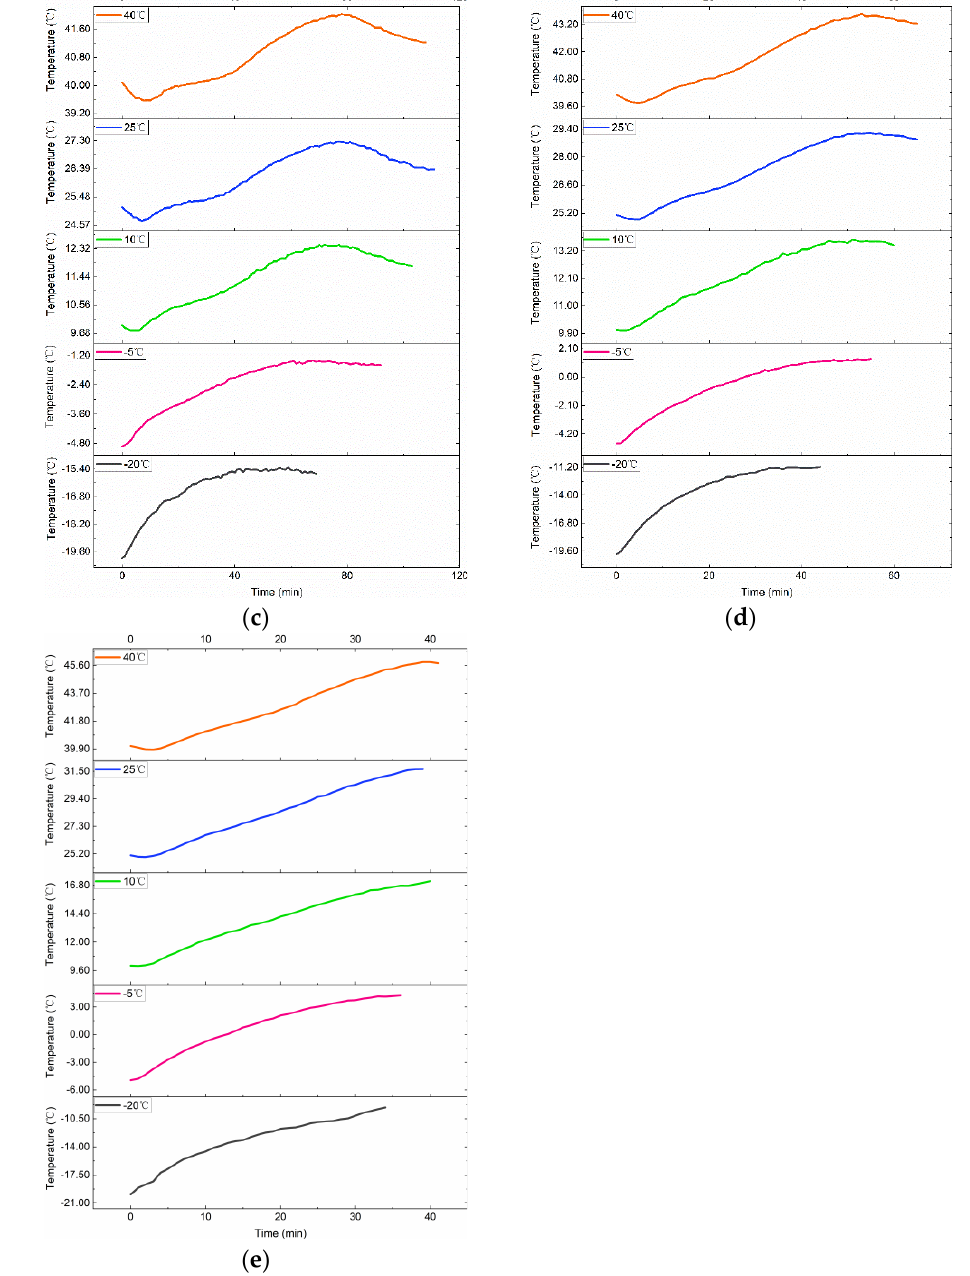
Figure 5. The battery surface’s temperature fluctuation pattern while charging: ( a ) 0.10C charge rate; ( b ) 0.25C charge rate; ( c ) 0.50C charge rate; ( d ) 0.75C charge rate; ( e ) 1.00C charge rate.